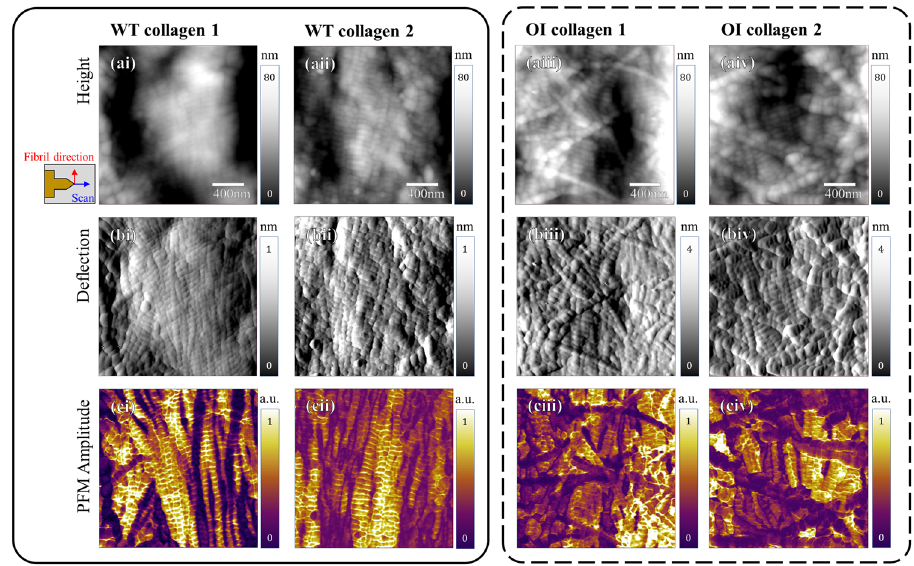
Fig. 5 PFM measured on WT and OI collagen matrices. PFM maps for a height, b de fl ection, and c PFM amplitude of WT and OI collagen matrices. In both WT and OI models, collagen fi brillar structures were exhibited with piezoelectricity. Although the WT collagen matrix was well-aligned in one direction, the OI collagen matrix exhibited a rather randomly aligned